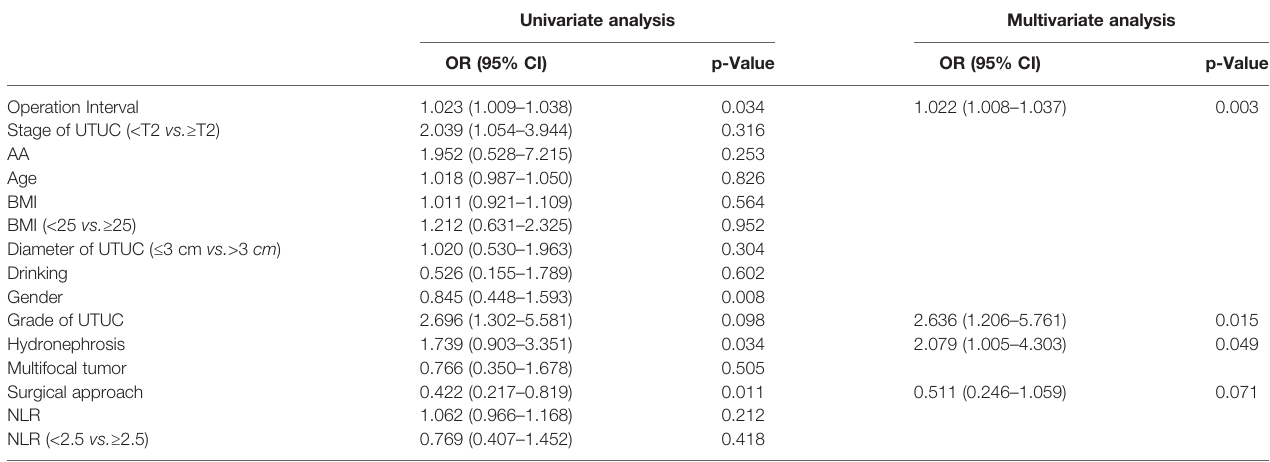
TABLE 3 | Univariate and multivariate analyses for factors associated with HGBC after RNU.